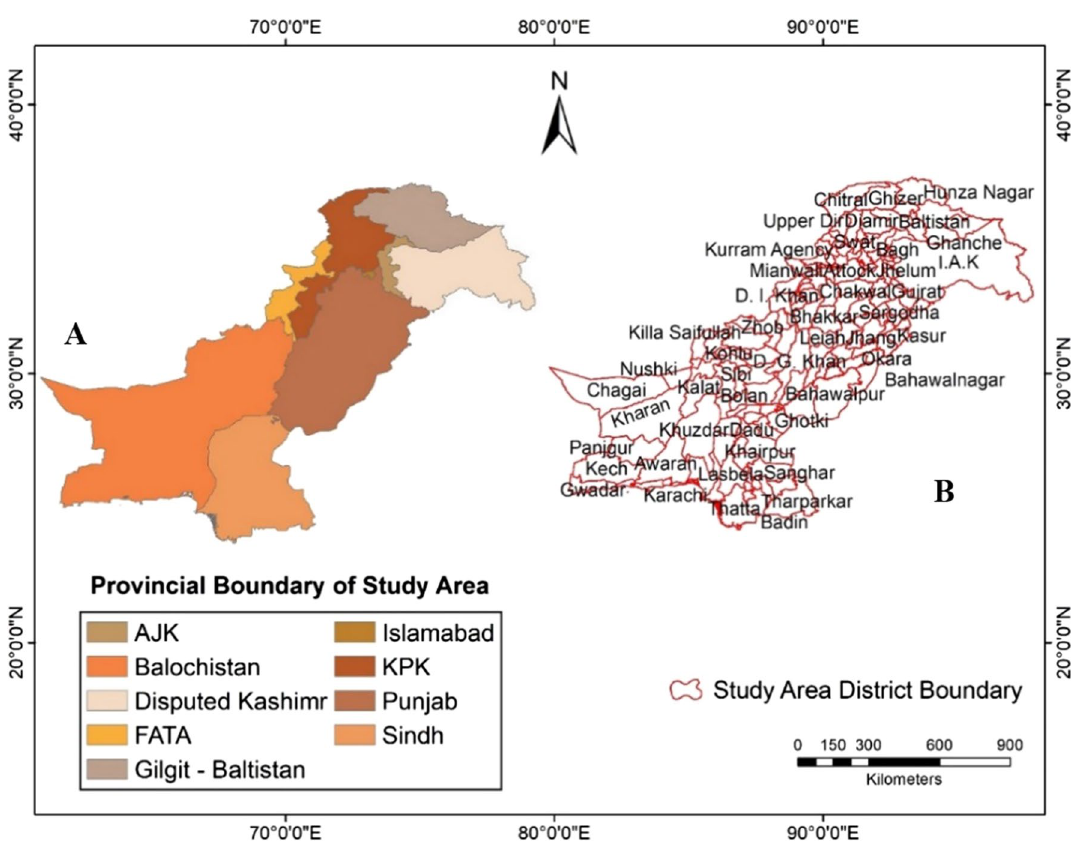
Fig. 1 Spatial location of Pakistan; A shows provincial boundaries of Pakistan, while B shows district boundaries of Pakistan. This figure shows the study area. Boundary of Pakistan in two prospects as A and B: A shows provincial boundary of Pakistan with different color sym-